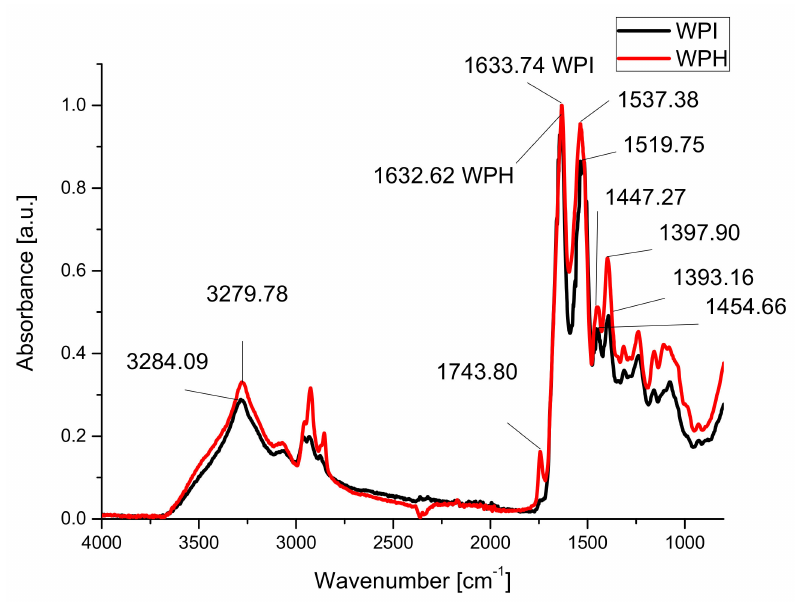
Figure 1. FTIR spectra of whey protein isolate (WPI) and whey protein hydrolysate (WPH). FT-IR spectra showed an increase in the intensities of absorption band centered around 1536 cm − 1 for the hydrolyzed sample compared to WPI due to the formation of primary amines following hydrolysis [74]. More than that, the band centered around 1400 cm − 1 (related to terminal -COOH group) (amide III [75]) also increased compared to the band from 1632 cm − 1 (amide I). A new absorption band appeared at around 1744 cm − 1 due to the formation of new carboxylic groups following enzymatic hydrolysis. Compared to amide I absorption band one can see increased of the intensity and area of the vibration band (3640–3097 cm − 1 ) due to the hydrogen bonds in the case of hydrolyzed